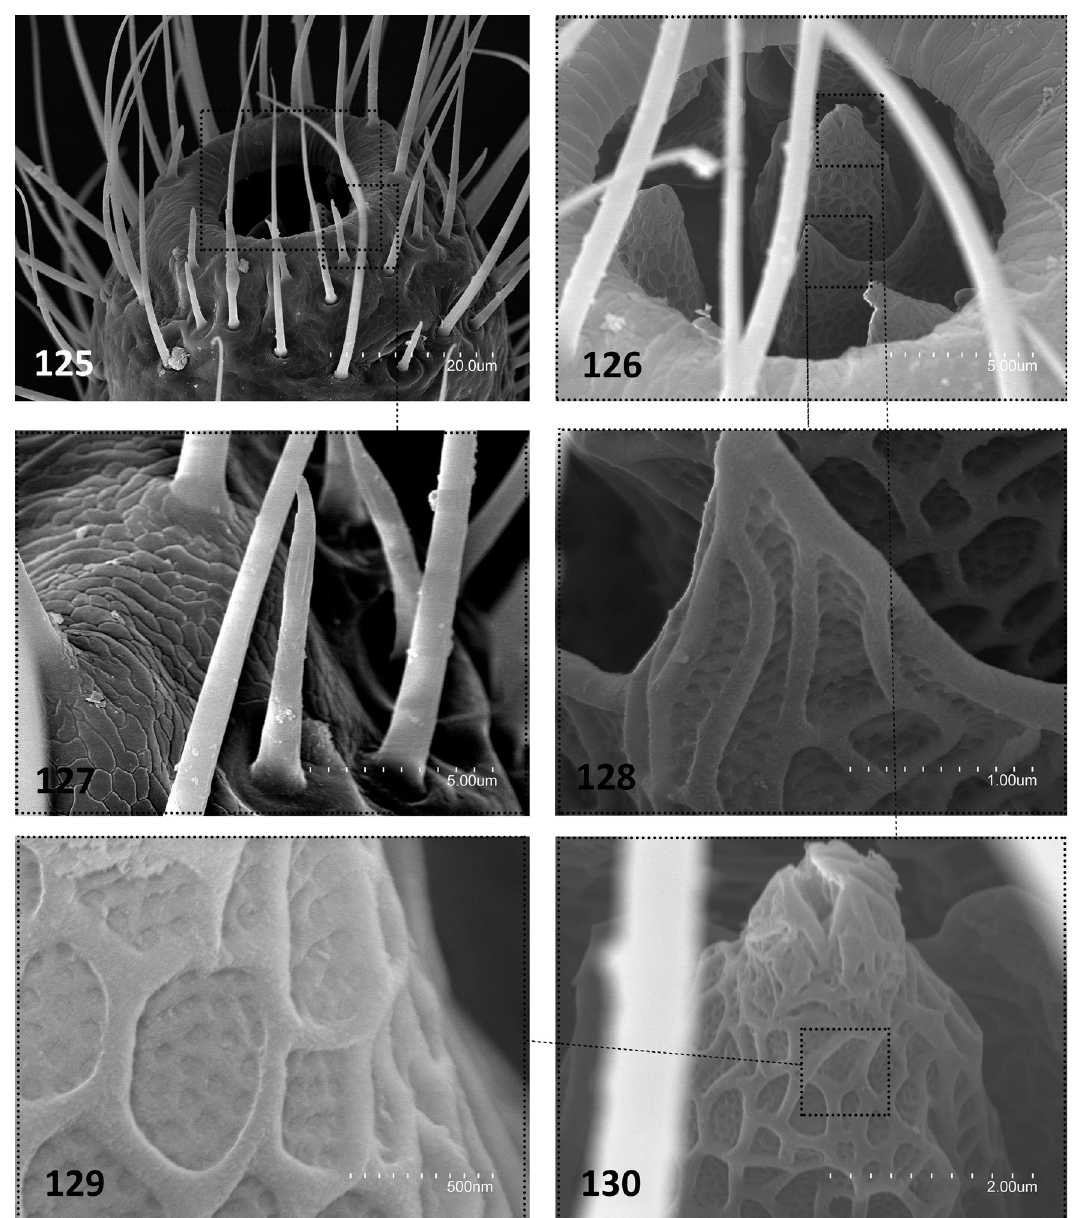
Figs 125–130. Plusiocampa ( Plusiocampa ) schweitzeri Condé, 1947, from Govještica, Banja stijena, Rogatica, Bosnia and Herzegovina (Coll. AS). 125 . Tip of last antennomere. 126 . Cupuliform organ. 127 . Detail of rim of cupuliform organ with a coniform sensillum. 128 . Olfactory chemoreceptor, detail. 129 . Apical portion of an olfactory chemoreceptor. 130 . Surface of olfactory chemoreceptor,